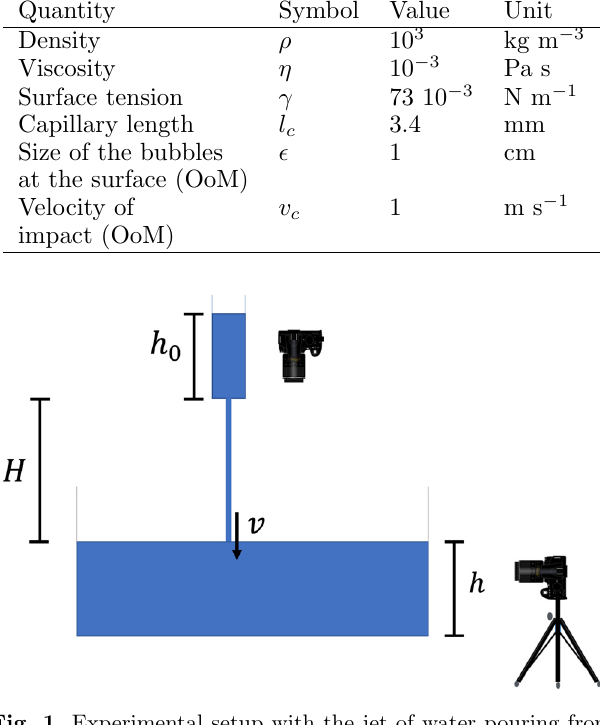
Fig. 1. Experimental setup with the jet of water pouring from a container of depth h 0 at a height H , with an impact velocity v , into a container of depth h .